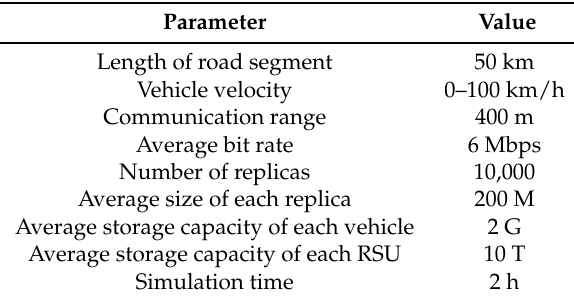
Table 2. Vehicle-level parameter configuration.